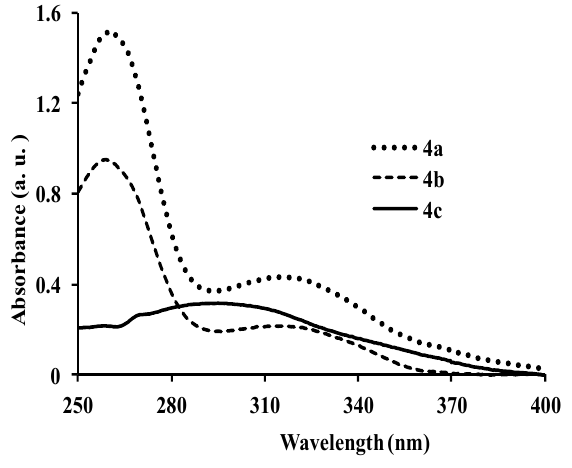
(conc. 2.0 × 10 − 7 mol/L). 3